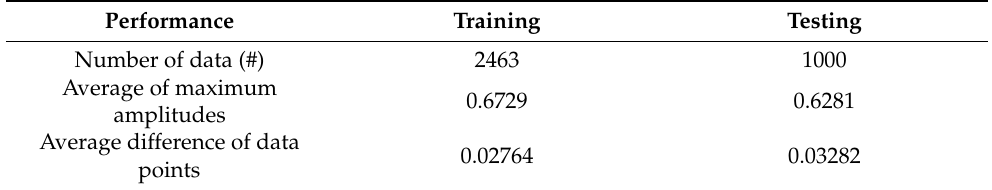
Table 3. Point-by-point comparison of extracted flaw data, training dataset, and testing dataset must.